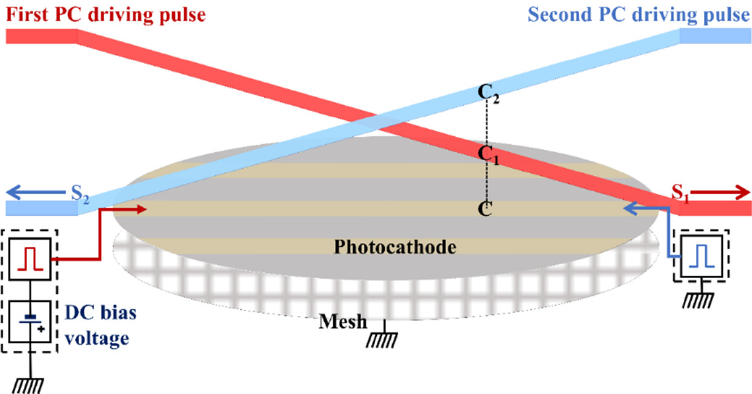
Figure 7. The relationship between the theoretical UXI frame size along the PC and the time resolution.